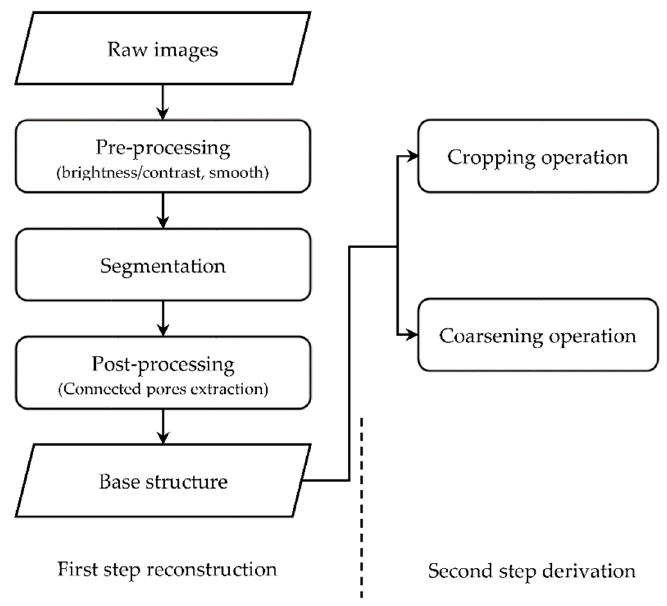
Figure 1. Procedure of two-step image processing.